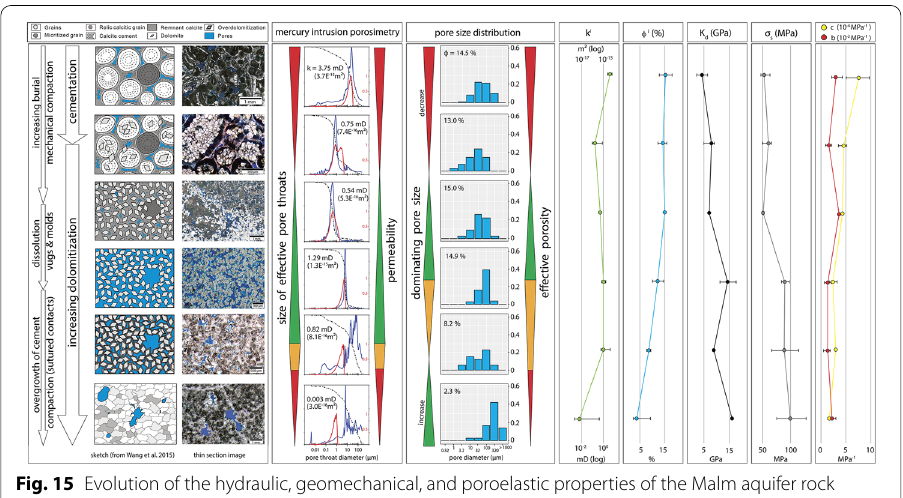
Fig. 15 Evolution of the hydraulic, geomechanical, and poroelastic properties of the Malm aquifer rock as a result of diagenetic processes. The porosity and geometry of the pores and pore throats are altered and rearranged in the different stages of diagenesis. From early to late burial diagenesis the porosity of the investigated samples mainly decreases. The distribution of pore throat diameters (blue lines) and the connectivity of the pore network (red lines) vary throughout the different stages and control the permeability of the rock. Rock strength increases with increasing dolomitization and decreasing porosity, while the stress sensitivity of porosity is decreasing simultaneously. The stress sensitivity of permeability depends on the connectivity of the pore network and the occurrence of micro-fractures and does not show a clear trend. See text for more details. Sketches are modified after Wang et al. (2015). k i —initial permeability, Φ i —initial effective porosity, K d —drained bulk modulus, σ d —rock strength, b —stress sensitivity coefficient of permeability, c —stress sensitivity coefficient of